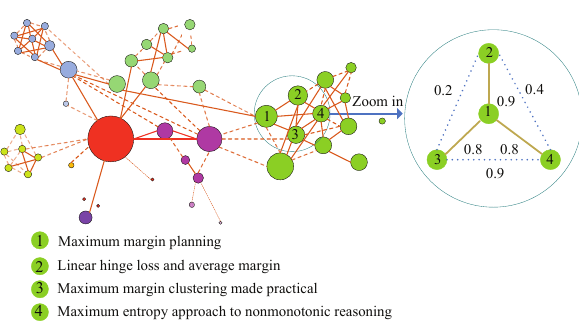
Fig. 1 Diagram of TFNR